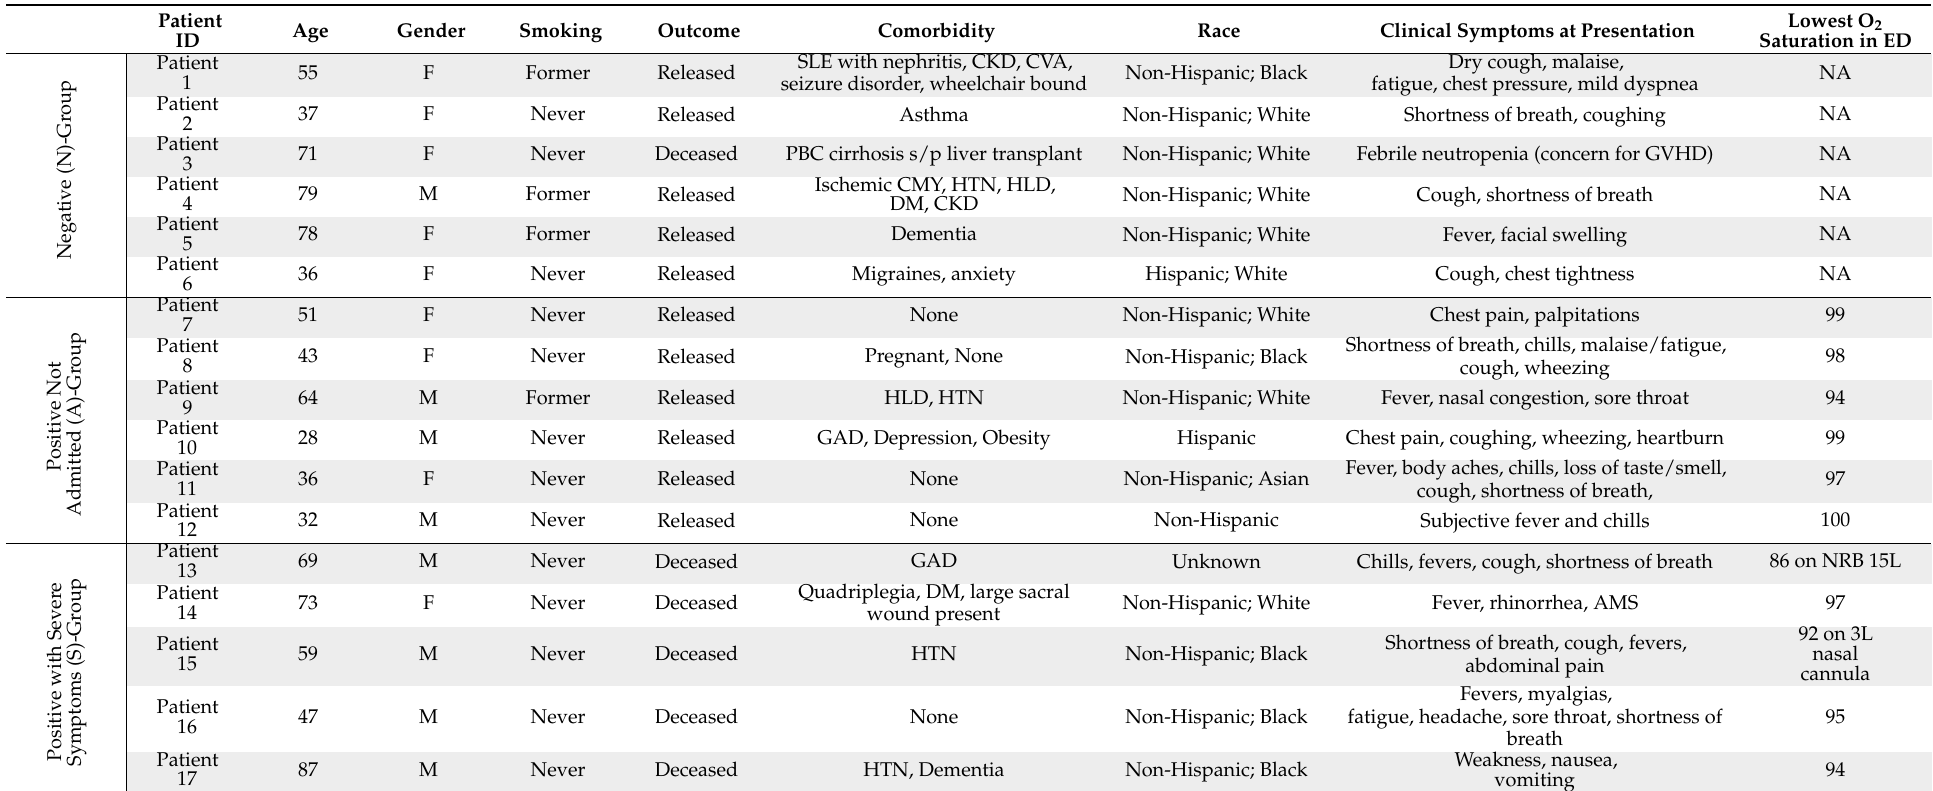
Table 1. Demographic Characteristics of COVID-19 patient